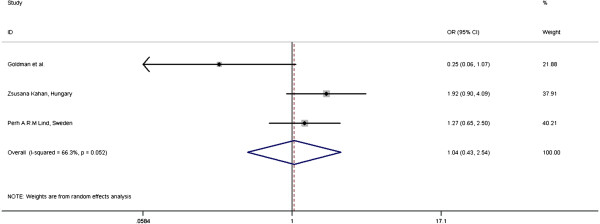
Meta-analysis: Effect of IMN irradiation on RP in 3D-CRT for BC.